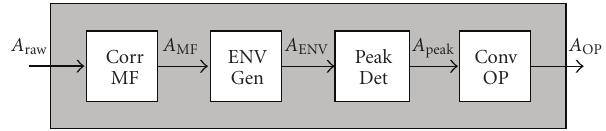
Figure 11: Complete processing chain of the adapted matched filtering [19] as implemented on the computing FPGAs. Firstly, we correlated the raw A-Scan with the matched filter signal (CorrMF). Then, we generated the absolute signal envelope (EnvGen) and in the following reduced it to its local maxima (PeakDet). Finally, the intermediate signal is convoluted with an optimal pulse for reflectivity imaging (ConvOP).